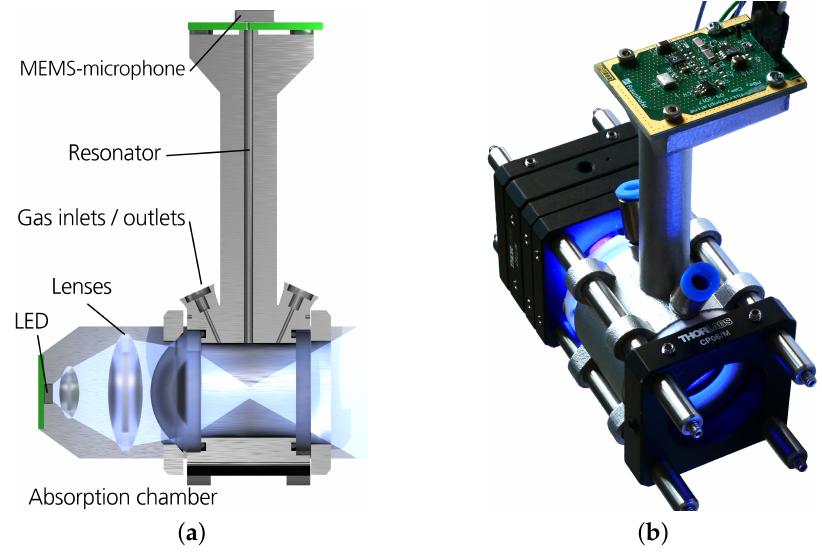
Figure 4. ( a ) Sensor setup in principle. ( b ) Picture of the setup with optical components mounted in a Thorlabs cage system (100 mm × 40 mm × 750